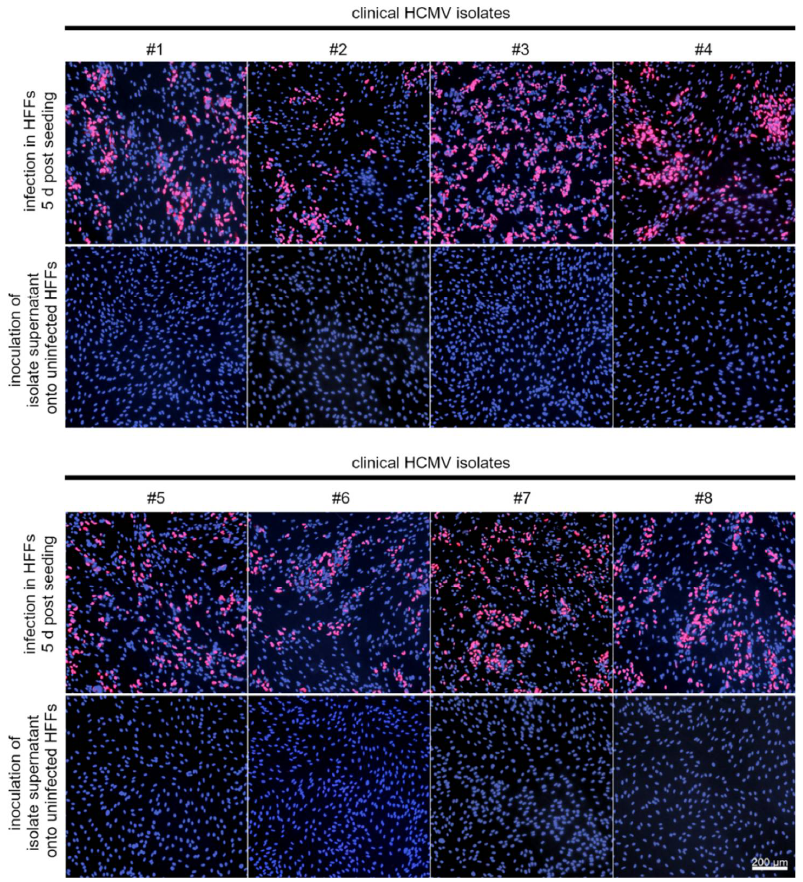
Figure 6. Hypothetical scheme of binding of PMNs to endothelial cells in the vascular lumen with the formation of virological synapses. PMNs can bind to receptors on endothelial cells such as ICAM-1, VCAM-1, and E-selectin via adhesion molecules such as LFA-1, VLA-4, and E-selectin ligand. The binding creates a spatial proximity between PMN and endothelial cells. This reaction space can serve for virus transmission and is often referred to as the virological synapse by analogy with the immunological synapse. Cell and receptor size as well as expression ratios are not shown realistically but are simplified to highlight predicted interactions.